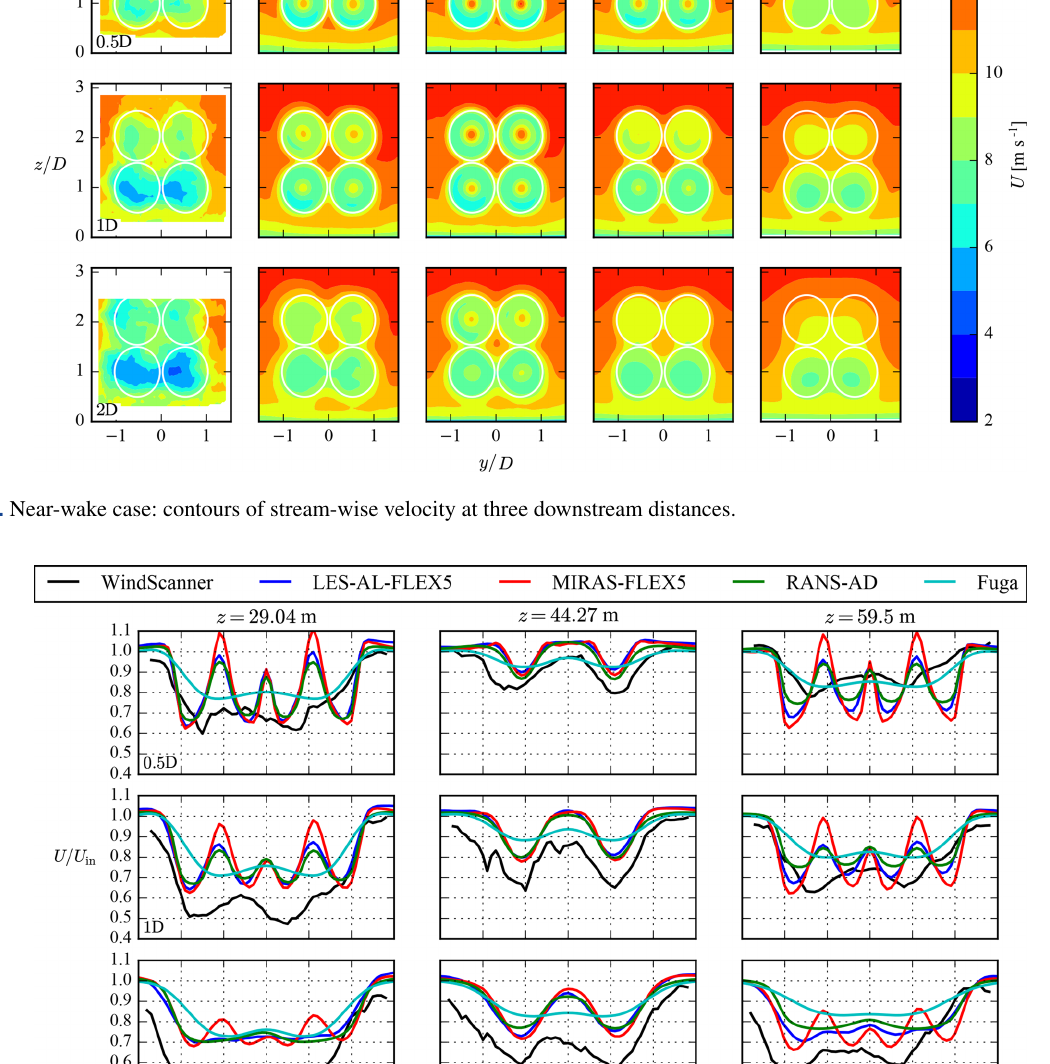
ence in the wake deficit between the top and bottom